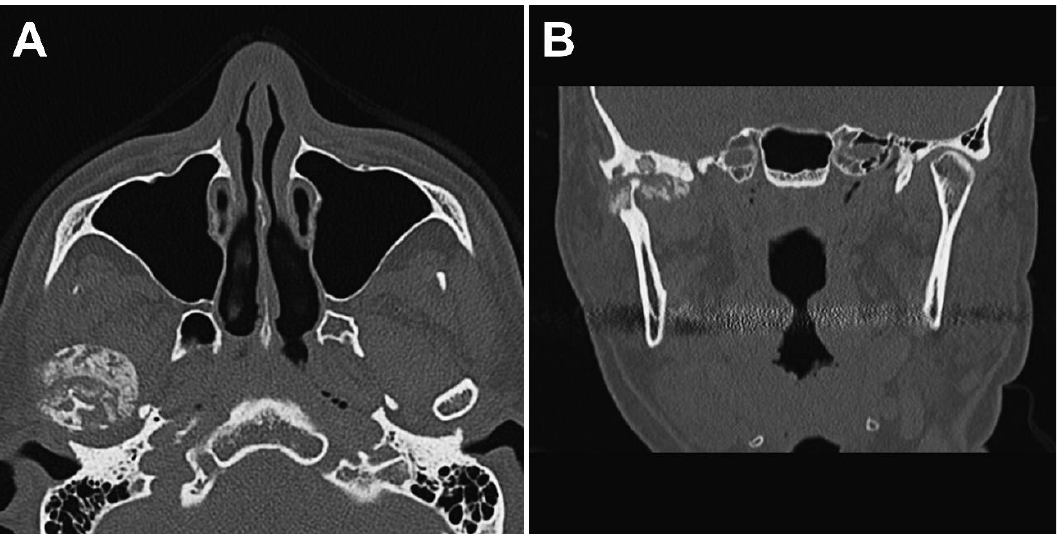
Figure 2. Preoperative computed tomography (CT) images. ( A ) Axial CT images showing the intra- articular localized, non-corticated, and ill-marginated calcified lesion that abuts the articular surface of the glenoid fossa around the right mandibular condyle. ( B ) Coronal CT images of the right tem- poromandibular joint revealed resorption of part of the mandibular condyle and cranial base.